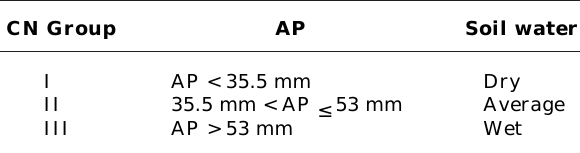
Table 1. Curve number (CN) groups, five-day antecedent precipitation (AP) and soil water condition